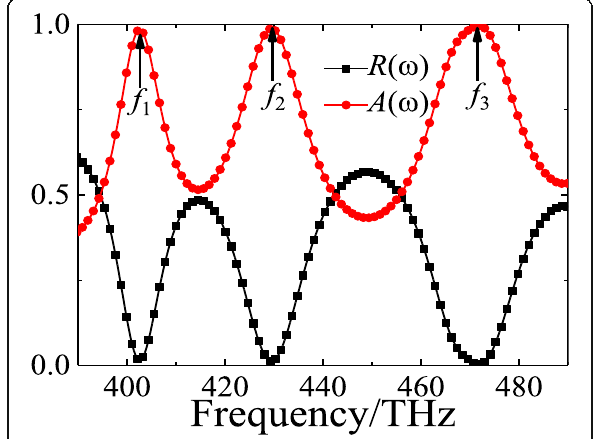
Fig. 2 The simulated reflectance ( R ( ω )) and absorbance ( A ( ω )) spectra of the designed visible hybrid metasurface-based PLA under normal incident light